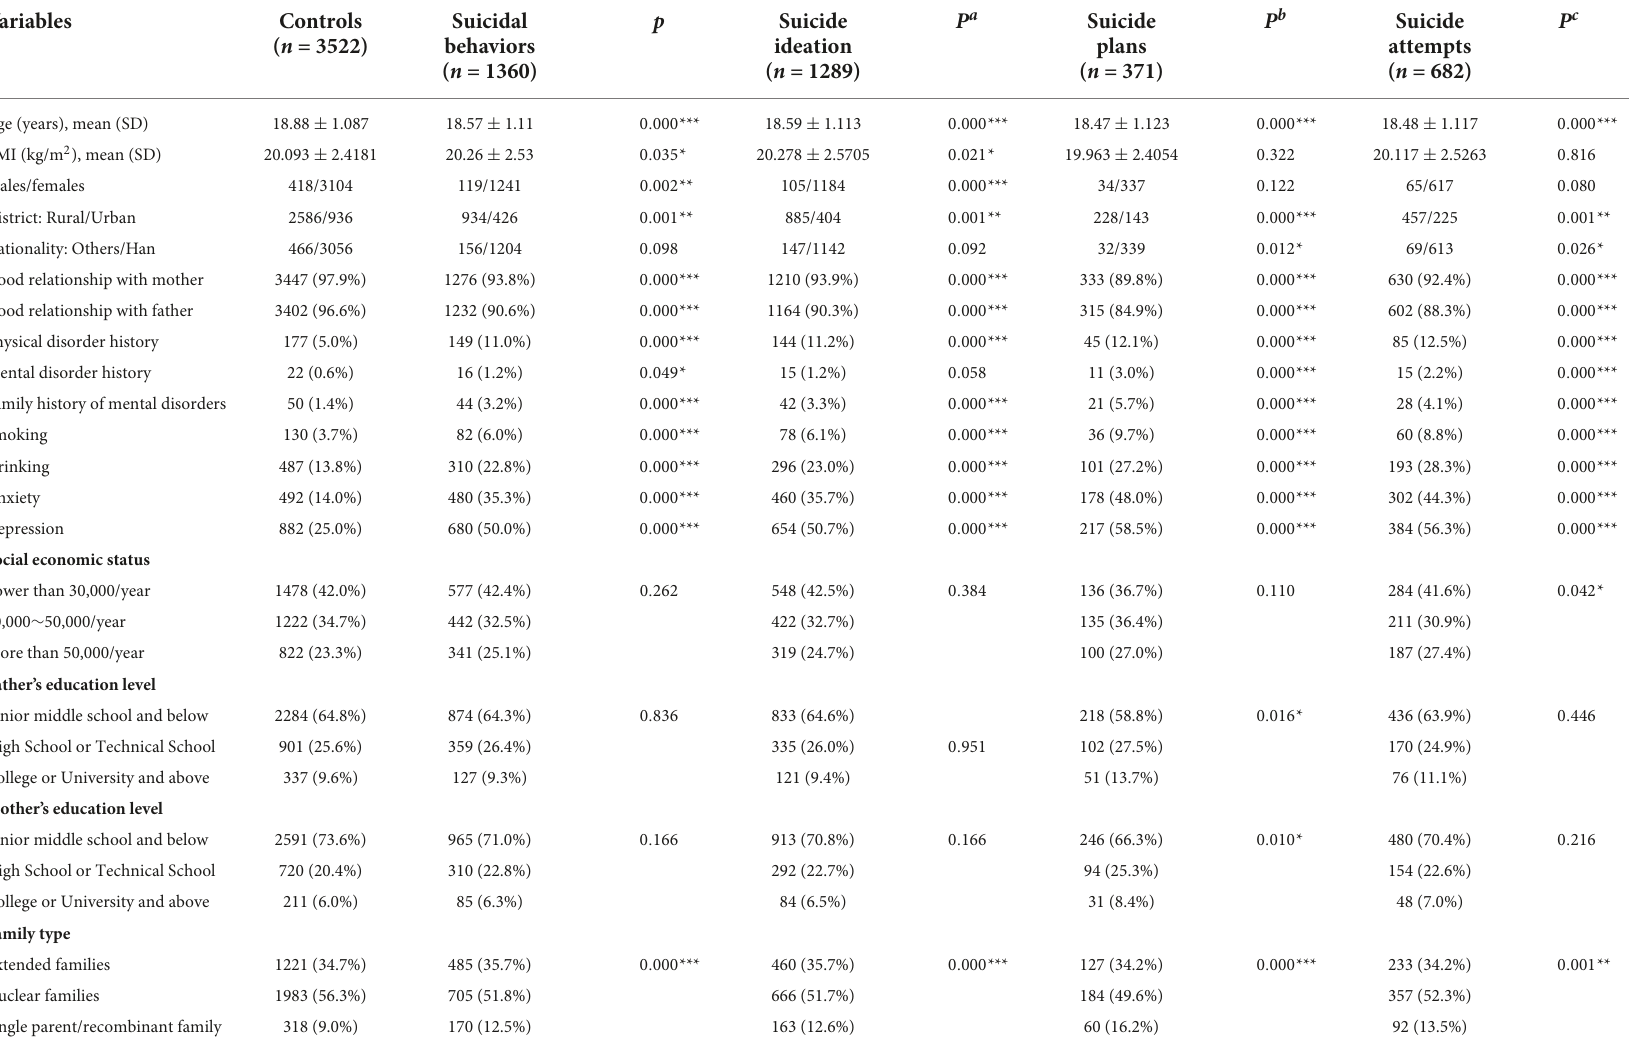
TABLE 1 Demographic characteristics of participants with suicidal behaviors and without suicidal behaviors